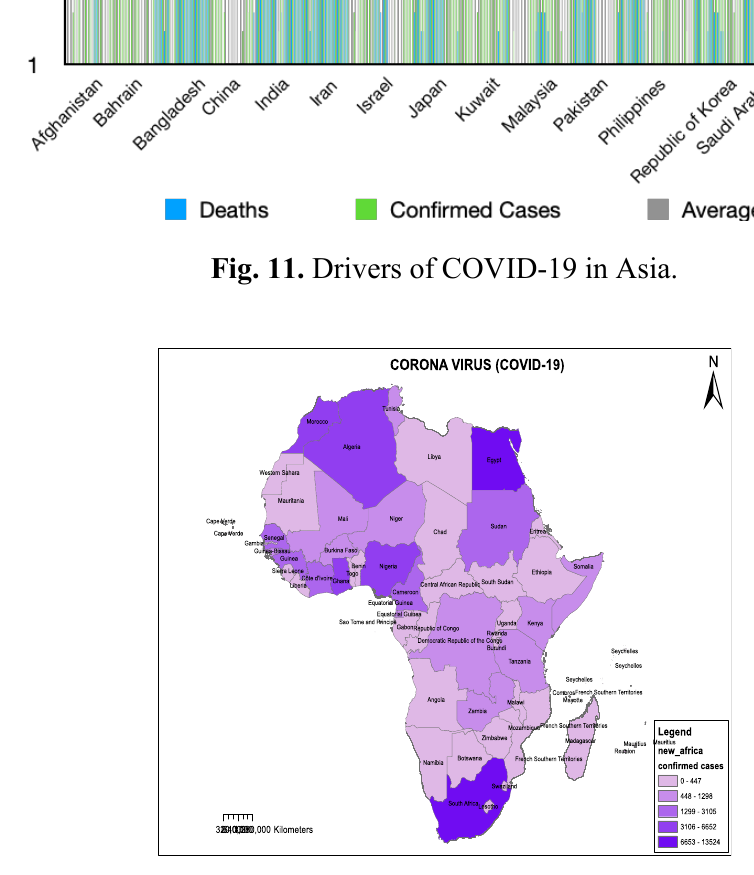
Fig. 12. Spatial distribution of confirmed cases in